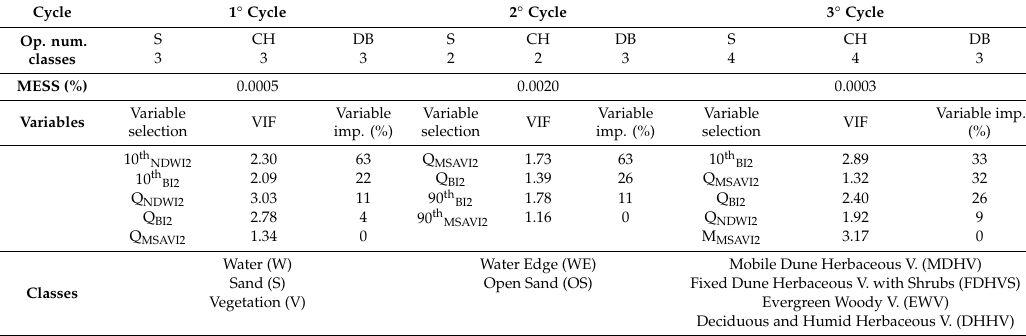
Table 2. Description of classification cycles (1 ◦ , 2 ◦ ,3 ◦ cycles) in terms of the optimal number of classes (Op. num. classes) according to Silhouette (S), Calinski–Harabasz (CH) and Davies–Bouldin (DB) indexes; the MESS values (%); the selected variables according to VIF selection, the variables’ importance in the definition of classes and the obtained cover classes (Classes). Q NDWI2 : temporal Rao of